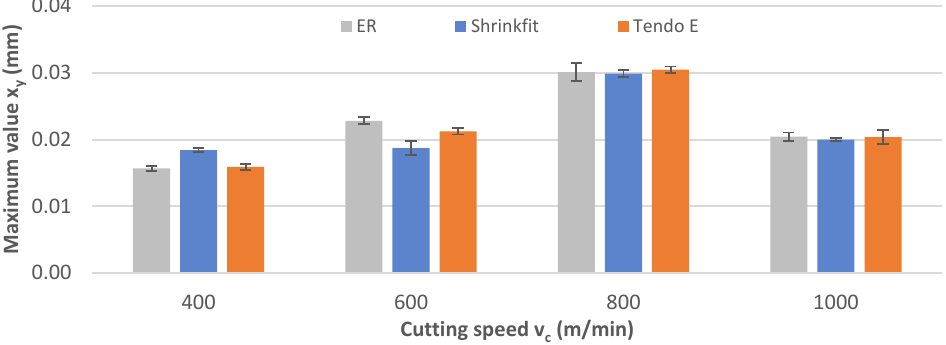
Figure 6. Impact of cutting speed v c on maximum vibration displacement value x y (f z = 0.15 mm/tooth, a p = 6 mm).